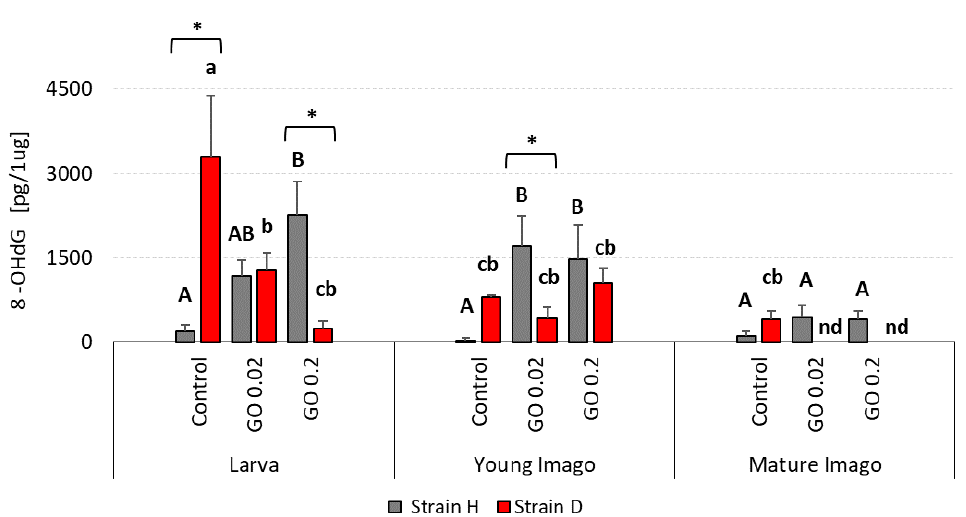
Figure 3. 8-OHdG (8-hydroxy- 2′ -deoxyguanosine) lesions in DNA in the gut cells of the wild (H) and long-living (D) strains of A. domesticus that had been chronically intoxicated with graphene oxide (GO). Measurements were conducted at larva (n = 5), young imago (n = 5) and mature imago stage (n = 5). Abbreviations: see Figure 1. Capital letters refer to strain H, while lowercase letters refer to strain D; asterisks indicate differences between the strains in each experimental group sep- arately.